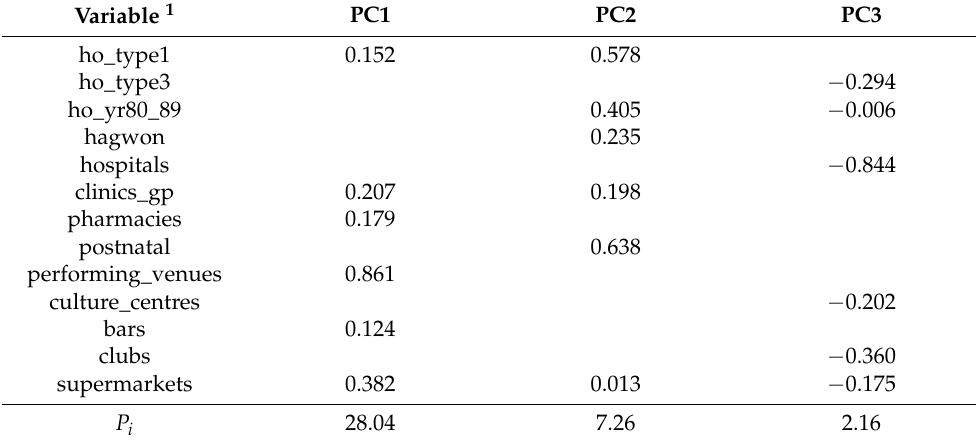
Table 3. Loadings of the first three PCs from the selected sparse PCA algorithm.